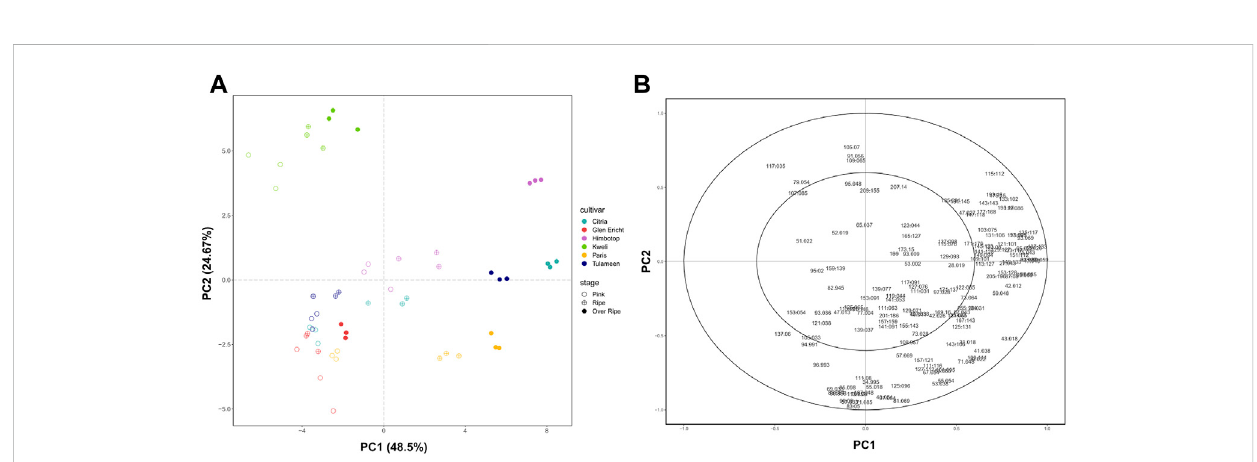
FIGURE 2 Evolution of raspberry VOC pro fi le during fruit ripening assessed by PTR-ToF-MS analysis Plot (A) depicts the VOC pro fi le of each raspberry cultivar ( “ Citria ” , “ Glen Ericht ” , “ Himbotop ” , “ Kweli ” , “ Paris ” , and “ Tulameen ” ) at three ripening stages [pink (P), ripe (R), and overripe (Or)] over the PCA score plotde fi ned by the fi rst two principal components. Plot (B) shows the PCA loading plot of the VOCs identi fi ed by PTR-ToF-MS